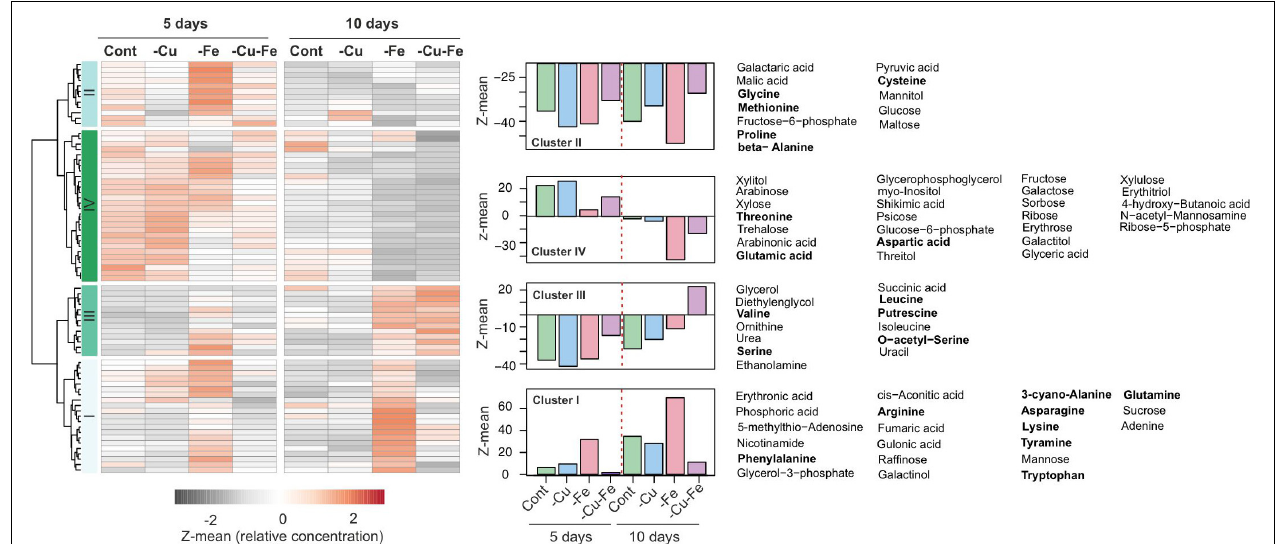
FIGURE 3 | Metabolome profiles in response to single and double deficiency of copper and iron. Heatmap with hierarchical clustering according to the Ward method with Z-means for the median of the relative concentration of metabolites from rosette leaves exposed to standard conditions (control, Cont), copper (–Cu), and iron (–Fe) deficiency or double deficiency (–Cu–Fe) for 5 ( n = 4) or 10 days ( n = 7) in Garcia-Molina et al. (2020; Supplementary Table 1 ). For each cluster in the heatmap the trend is depicted as the average of the Z-mean of the compounds along with the name of the metabolites. Amino acids are highlighted in